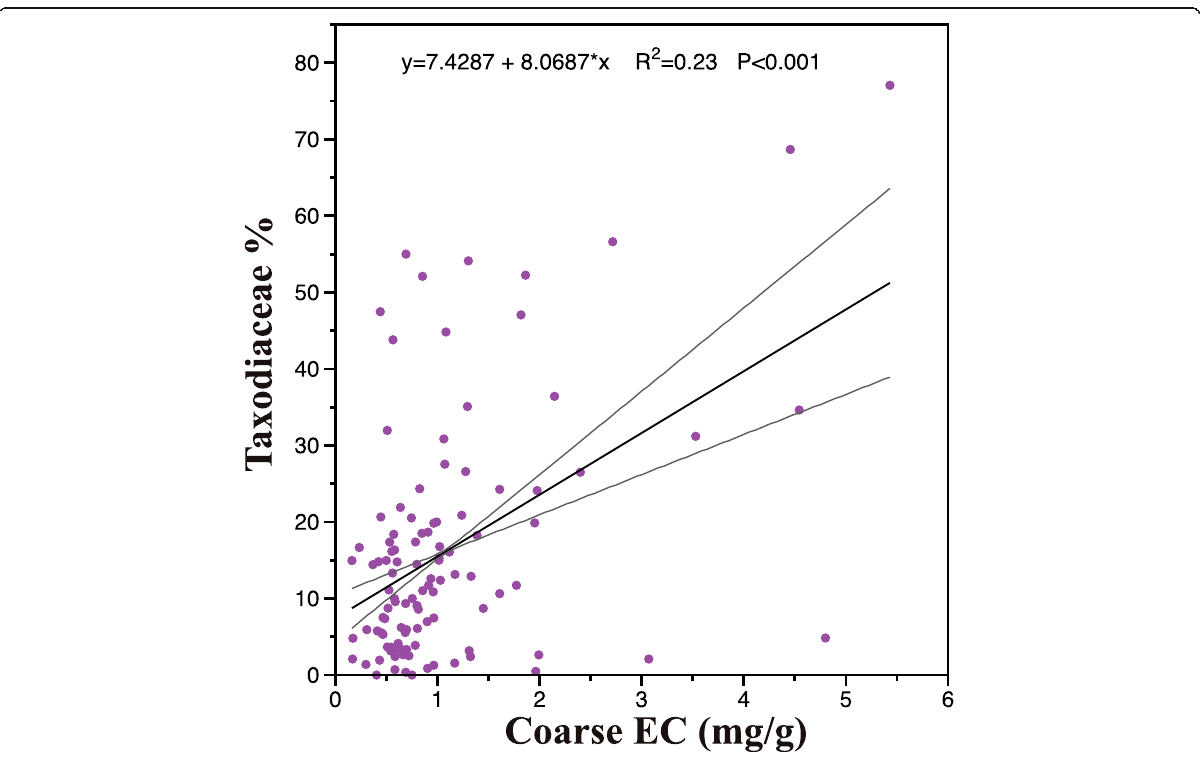
Fig. 7 Relationship between Taxodiaceae and EC content in the coarse fraction at site U1423. The gray lines represent the 95% of confidence interval envelopes